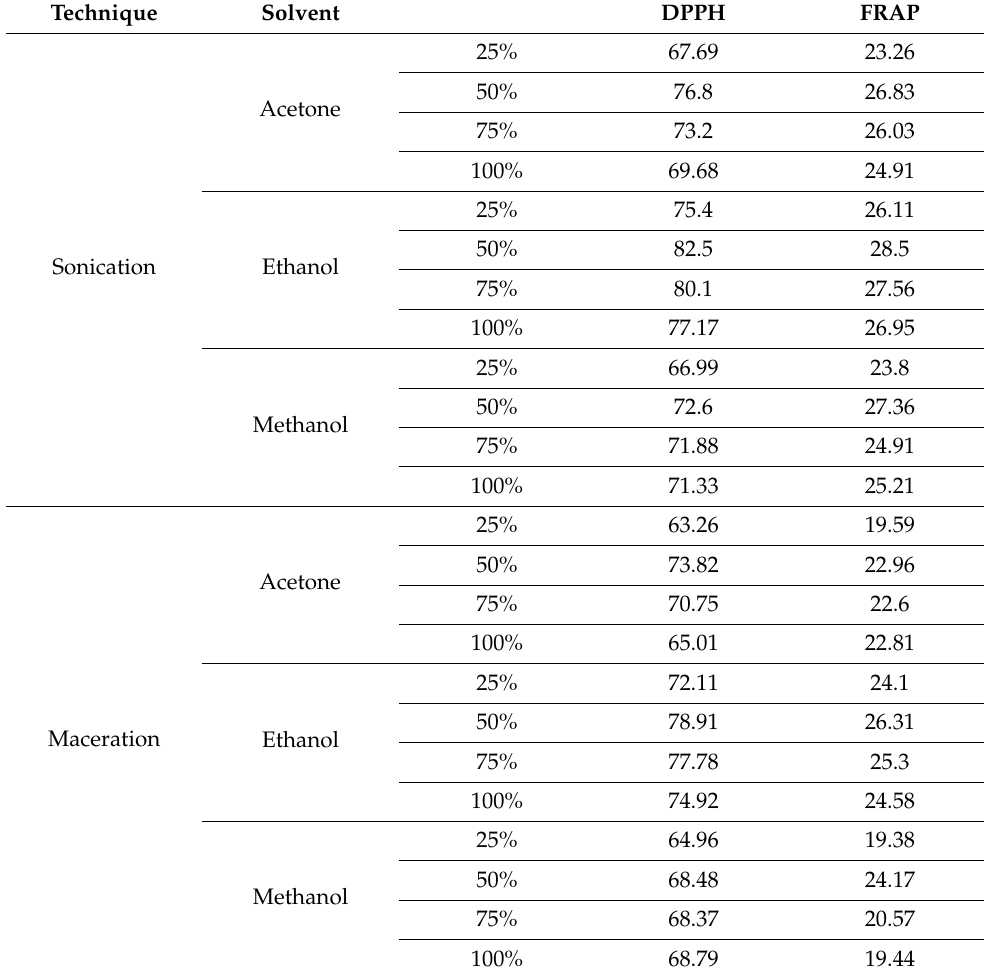
Table 2. Antioxidant Potential of Banana Peel